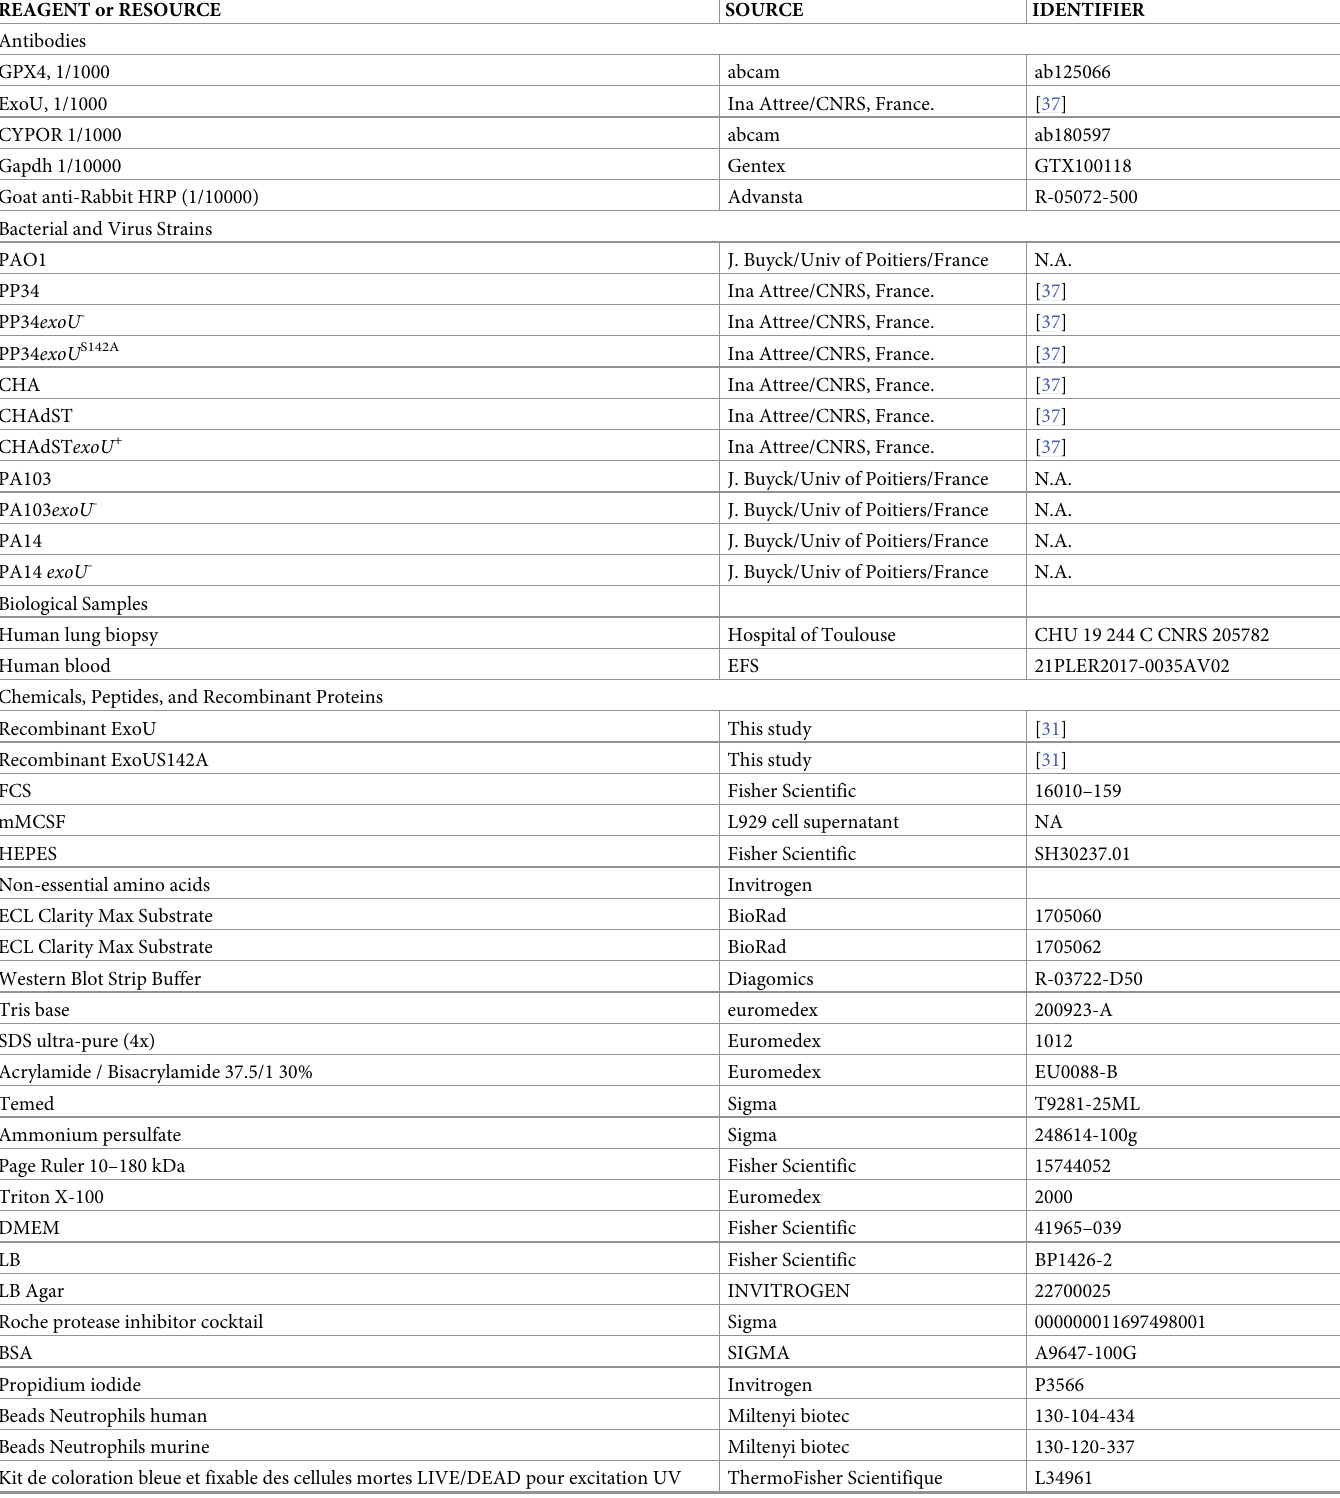
Table 1. Resource of reagents used in this study. Information and reagents are available upon request to Etienne.meunier@ipbs.fr. REAGENT or